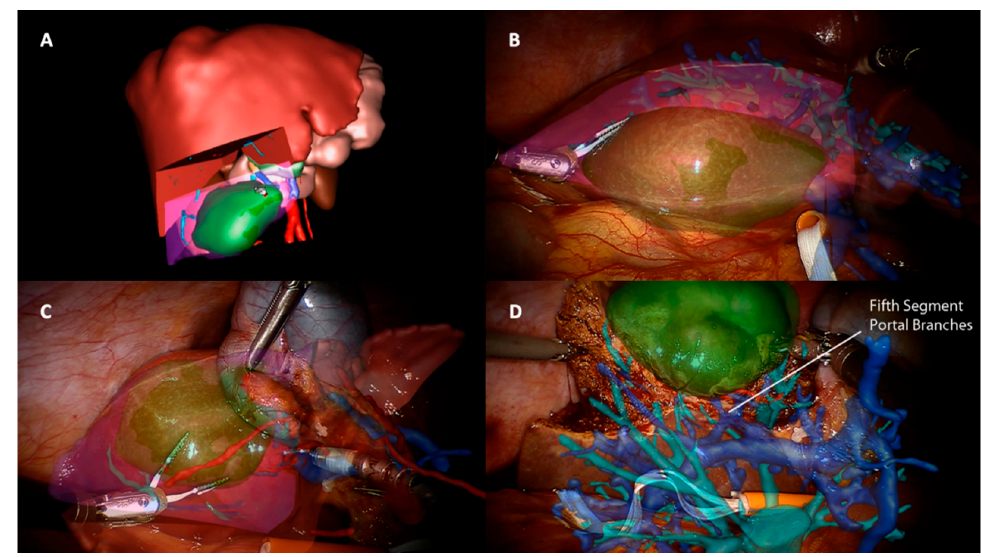
Figure 1. ( A ) Surgical preoperative planning through 3D reconstruction of an anatomical S5 seg ‐ mentectomy. The tumor is colored in green and the theorical resection plane in red. ( B – D ) Intraoper ‐ ative superimposition of planned resection area rendering. Vascular and biliary structures are pro ‐ jected during different phases of parenchymal transection, with the identification of the S5 vascular pedicle.